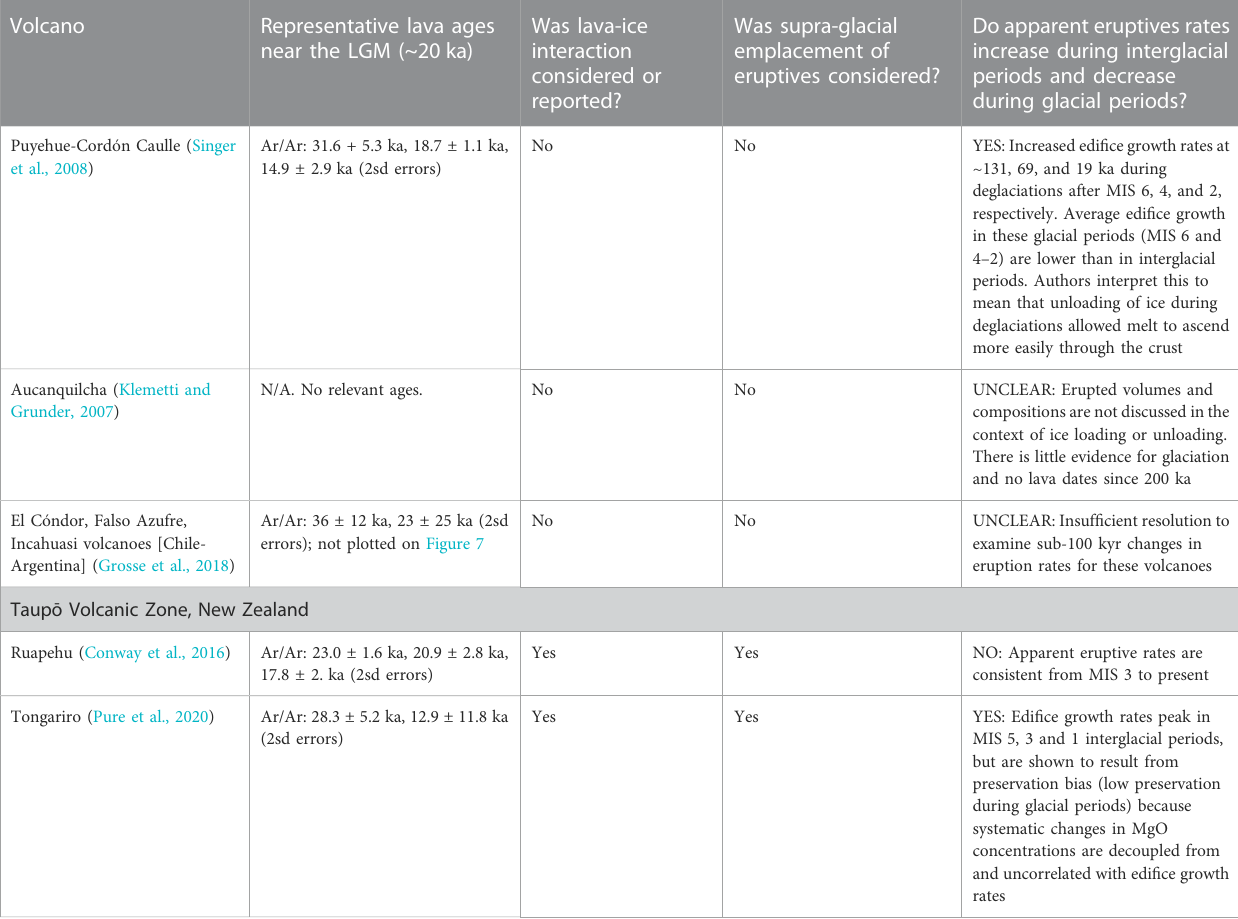
TABLE 2 ( Continued ) Summary of geochronological precision, preservation considerations, and time-volume correlations with climatic changes. The radiometric ages and other summarized information are from the references in Table 1, unless otherwise noted.